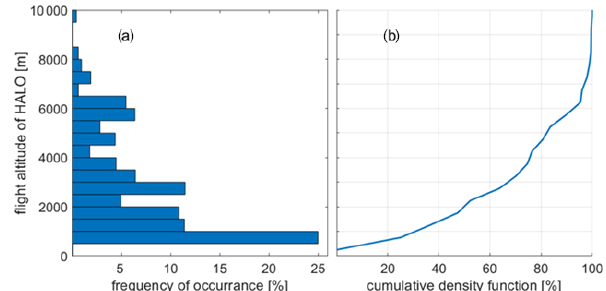
Figure 5. Frequency of occurrence of flight altitudes during EMeRGe in Europe in bins of 500m, (a) cumulated frequencies of flight altitudes from the ground to 10000m, and (b) cumulative density